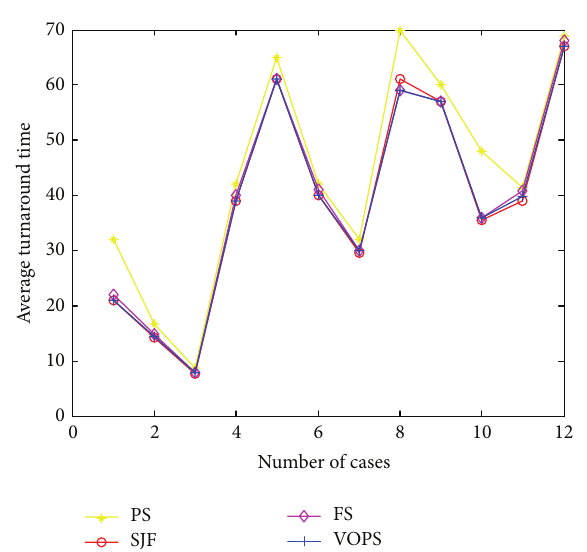
Figure 10: Average turnaround time.